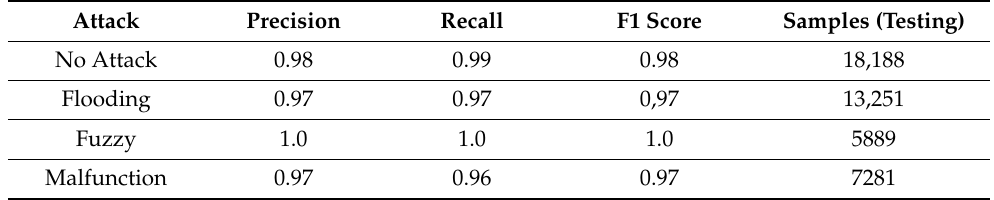
Figure 11. Confusion Matrix of KNN (Dataset 2). Table 8. Detection performance of flooding, fuzzy, malfunction, and attack-free for KNN (Dataset 2).